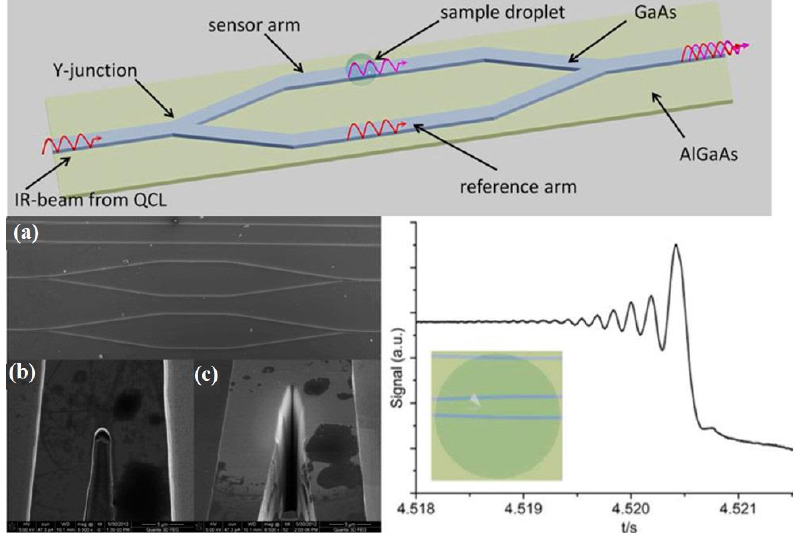
Figure 6. ( top ) Scheme of an on-chip MIR Mach − Zehnder interferometer. ( bottom left ) Scanning electron microscopy (SEM) images of MIR-MZI waveguides show ( a ) a top view of GaAs/AlGaAs MZIs, and the Y-junction ( b ) before and ( c ) after using focused ion beam (FIB) microscopy for refining the structure for the joint of the waveguide arms. ( bottom right ) Typical interferometric signal generated by depositing, e.g., water droplets at one of the MZI arms, resulting in a phase delay and giving rise to the observed interference pattern. Reproduction requires permission from ref. [91]. Copyright 2013 the American Chemical Society.